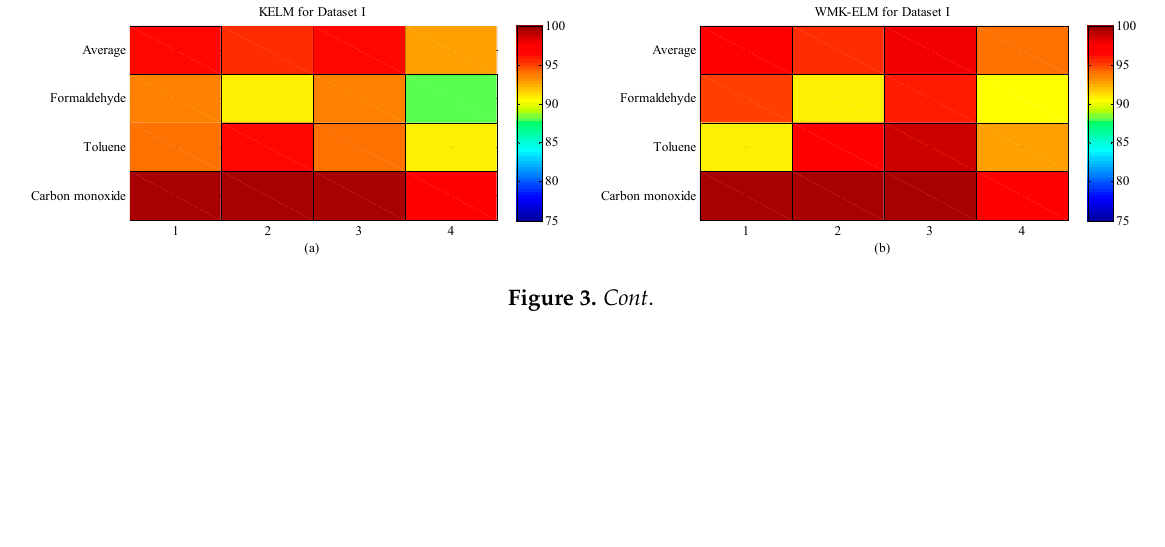
Figure 3. Classification results of QWMK-ELM and KELM for Dataset I and Dataset II. (Note: QWMK- ELM and KELM represent the quantum-behaved particle swarm optimization (QPSO)-based weighted multiple kernel extreme learning machine and kernel extreme learning machine respectively. In subplots ( a ) and ( c ), 1, 2, 3, and 4 represent Gaussian-kernel, polynomial-kernel, wavelet-kernel, and sigmoid-kernel, respectively. In subplots ( b ) and ( d ), 1, 2, 3, and 4 represent weighted-Gaussian-kernel, weighted-polynomial-kernel, weighted-wavelet-kernel, and weighted- sigmoid-kernel.) 5.3. Performances of Other Contrast Classification Models In order to further certify the advantages of QWMK-ELM in classification, we perform an explicit comparison between QWMK-ELM and other classification methods. A host of different classifiers, i.e., ELM, MLP-BP, RBFNN, PNN, KNN, and SVM, are used as contrasts to demonstrate the validity of the proposed methods. Tables 5 and 6 display the classification accuracies among different methods for Dataset I and Dataset II, respectively. From Tables 5 and 6, we can see that all classifiers performed consistently well for both datasets, and most of them obtained accuracies of more than 90%, except for KNN for Dataset II, which has an accuracy lower than 80%. In addition, it is interesting to note that the overall trend of the classification results of different methods for Dataset I is in accord with that for Dataset II (shown in Figure 4). The proposed QWMK-ELM classifier consistently has the highest accuracies for both datasets and can attain 97.90% and 95.57% accuracies, respectively, while the KNN has the worst performances for both datasets, which are much lower than those of the other classification methods. This indicates that QWMK-ELM has an obvious advantage over other control classification methods. Comparing Tables 5 and 6, we also can find that under the condition of uneven class sizes in the samples, the advantages of QWMK-ELM are more obvious, as it can choose a more appropriate kernel function to reflect the characteristics of the training data and thus has stronger generalization and robustness. Table 5. Classification accuracy of QWMK-ELM and the control methods for Dataset I. Class